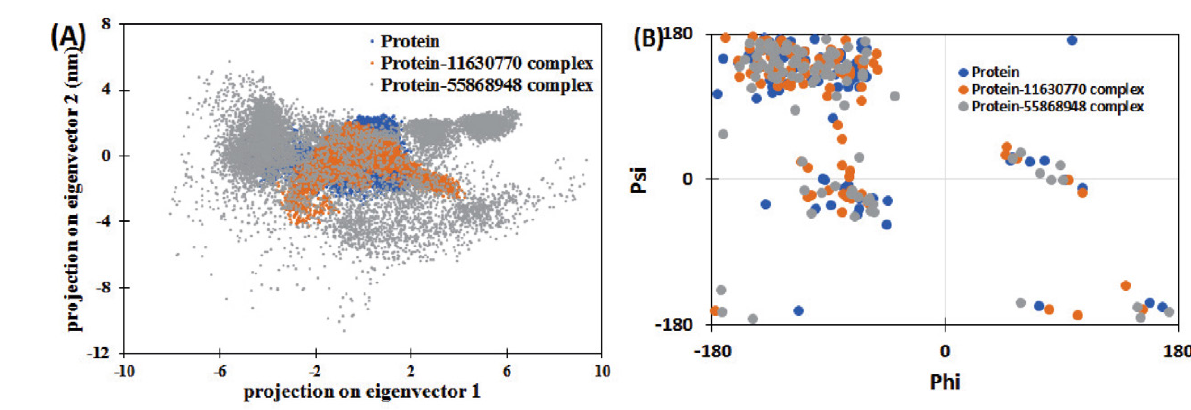
Fig. 12. (A) Principal component analysis (PCA) of HIV-1 protease in the absence and presence of 11630770 and 55868948. (B) Ramachandran plot of the energy minima of HIV-1 protease in the absence and presence of 11630770 and 55868948.